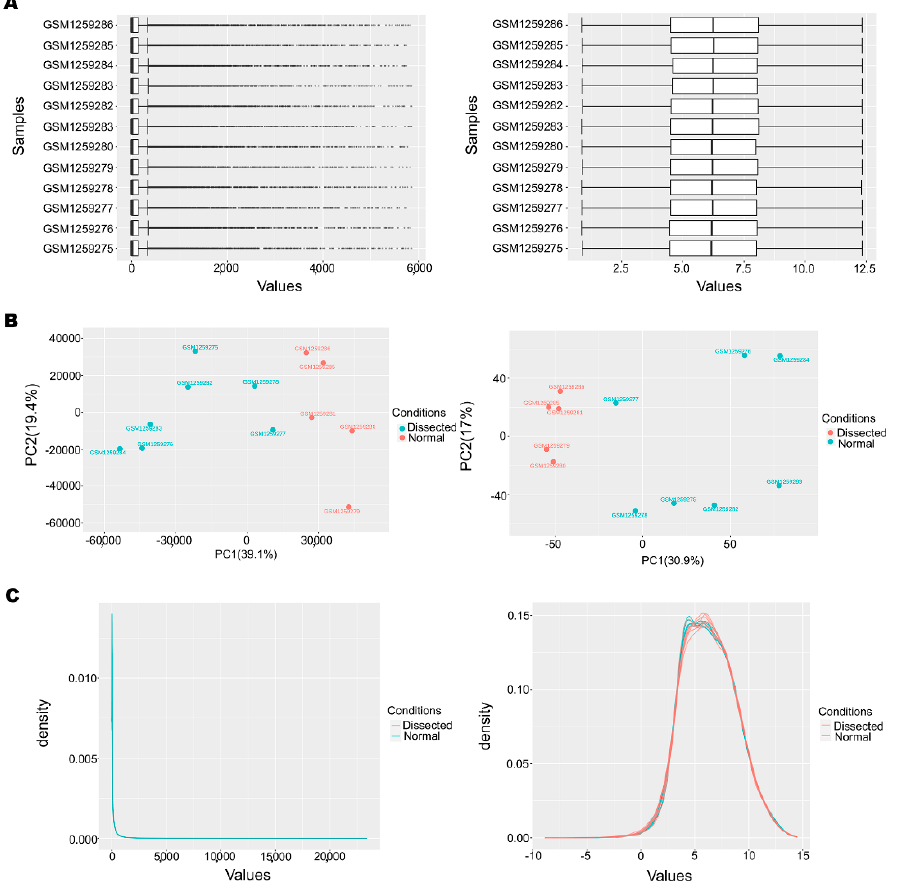
Figure 1. Data normalization. ( A ). The box plots of data before and after normalization. ( B ). The principal component analysis (PCA) plot of data before and after normalization. ( C ). The density plot of data before and after